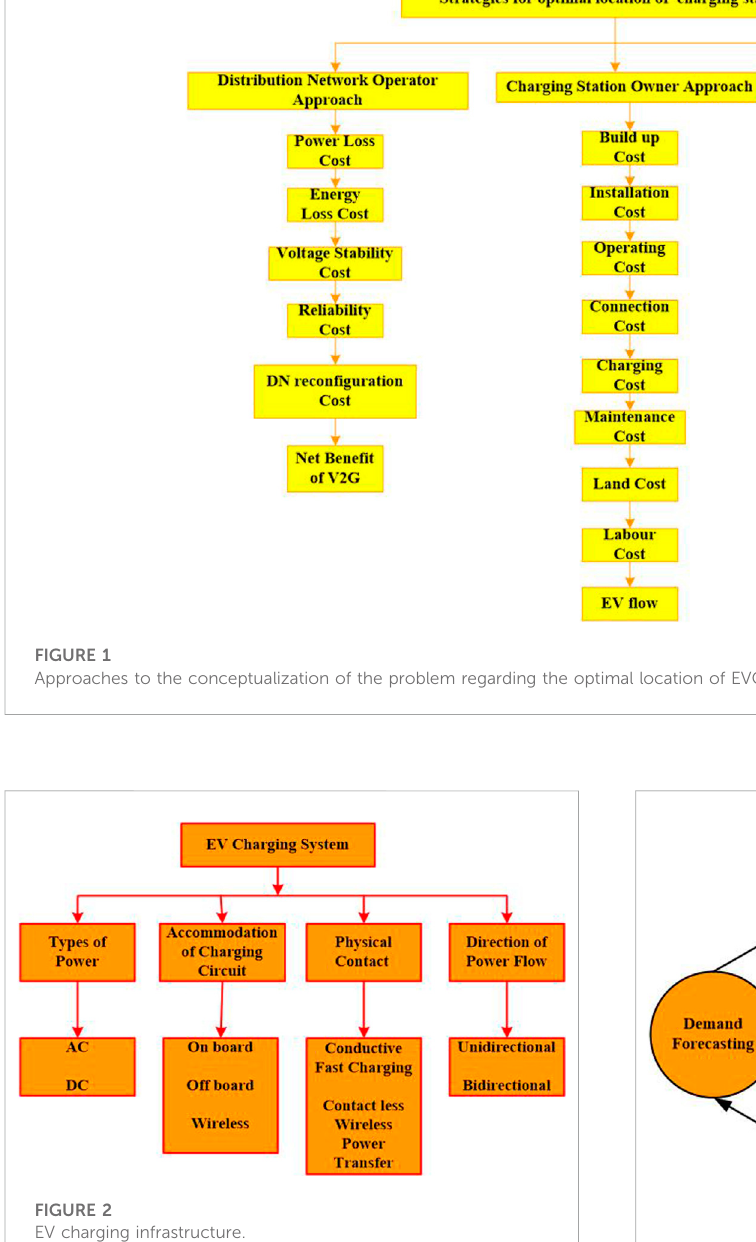
FIGURE 2 EV charging infrastructure.